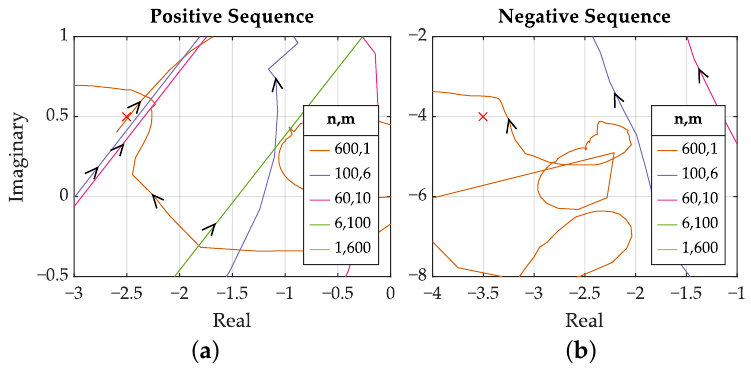
Figure 27. Nyquist plots of grid-forming MMC and offshore wind farm impedance ratio for different wind farm grid layouts.